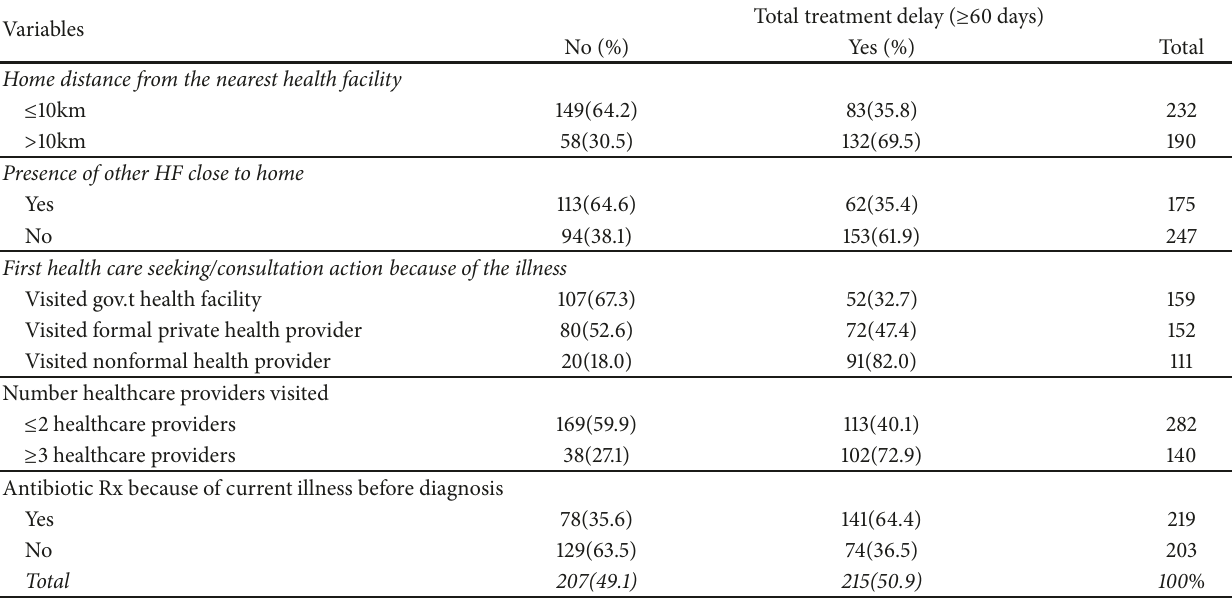
Table 8: Distribution of total treatment delay among health accessibility & health seeking behaviors of the study participants in selected health facilities of Gedeo Zone, Southern Ethiopia,